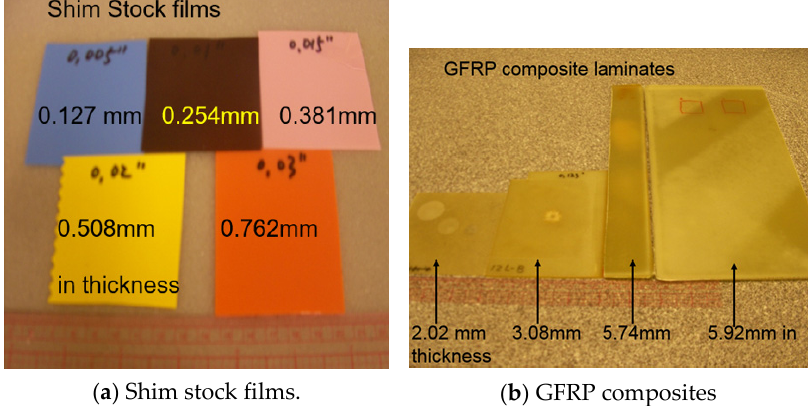
Figure 4. Samples of ( a ) Shim Stock films and ( b ) GFRP composites with various thicknesses.